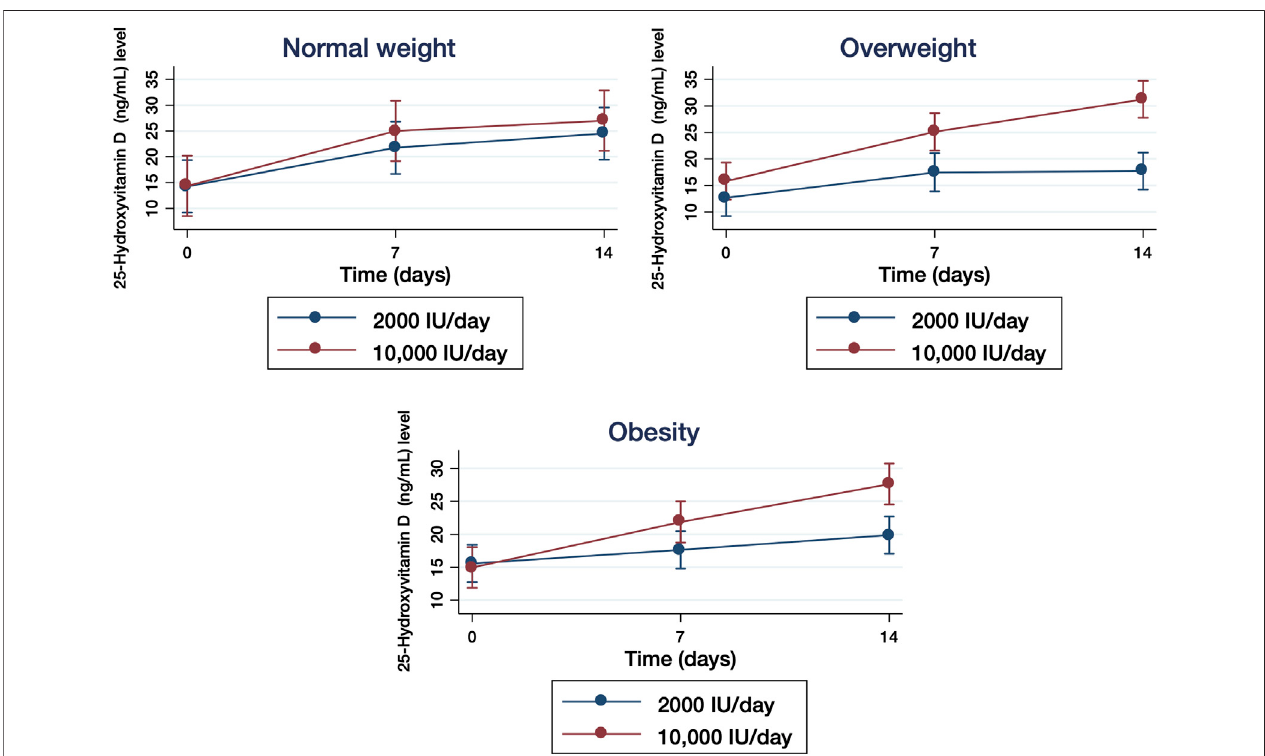
FIGURE 3 | Quanti fi cation of serum 25-hydroxyvitamin D (25(OH)D) levels in hospitalized patients with COVID-19 who received 2000 IU/day and 10,000IU/day of cholecalciferol classi fi ed by the body mass index in normal-weight (BMI:18-5 – 24.99), overweight (BMI: 25.0 – 29.9) and obese (BMI ≥ 30) participants measured at baseline (day 0) and after 7 and 14 days of treatment. The results are presented as means ±95% of con fi dence